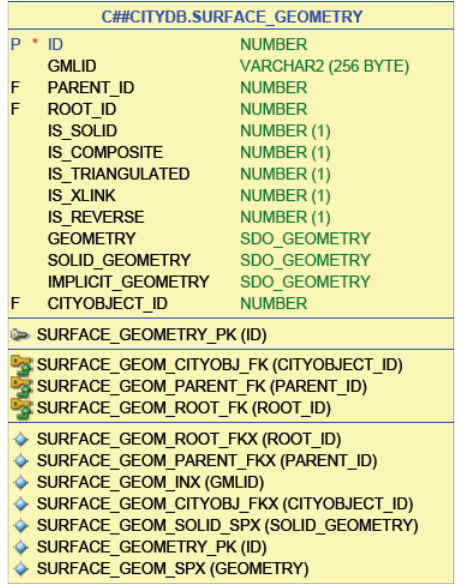
Figure 14. Spatial table that contains multiple geometry